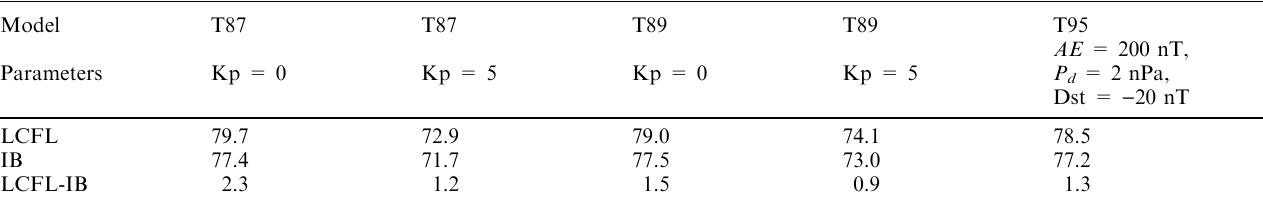
Table 1. Latitudes of isotropic boundary of 80 keV protons (IB) and of the last closed field line (LCFL) at noon meridian as well as the minimal width of isotropic precipitation (LCFL-IB) in di(cid:128)erent magnetospheric models Model T87 T87 T89 T89 T95